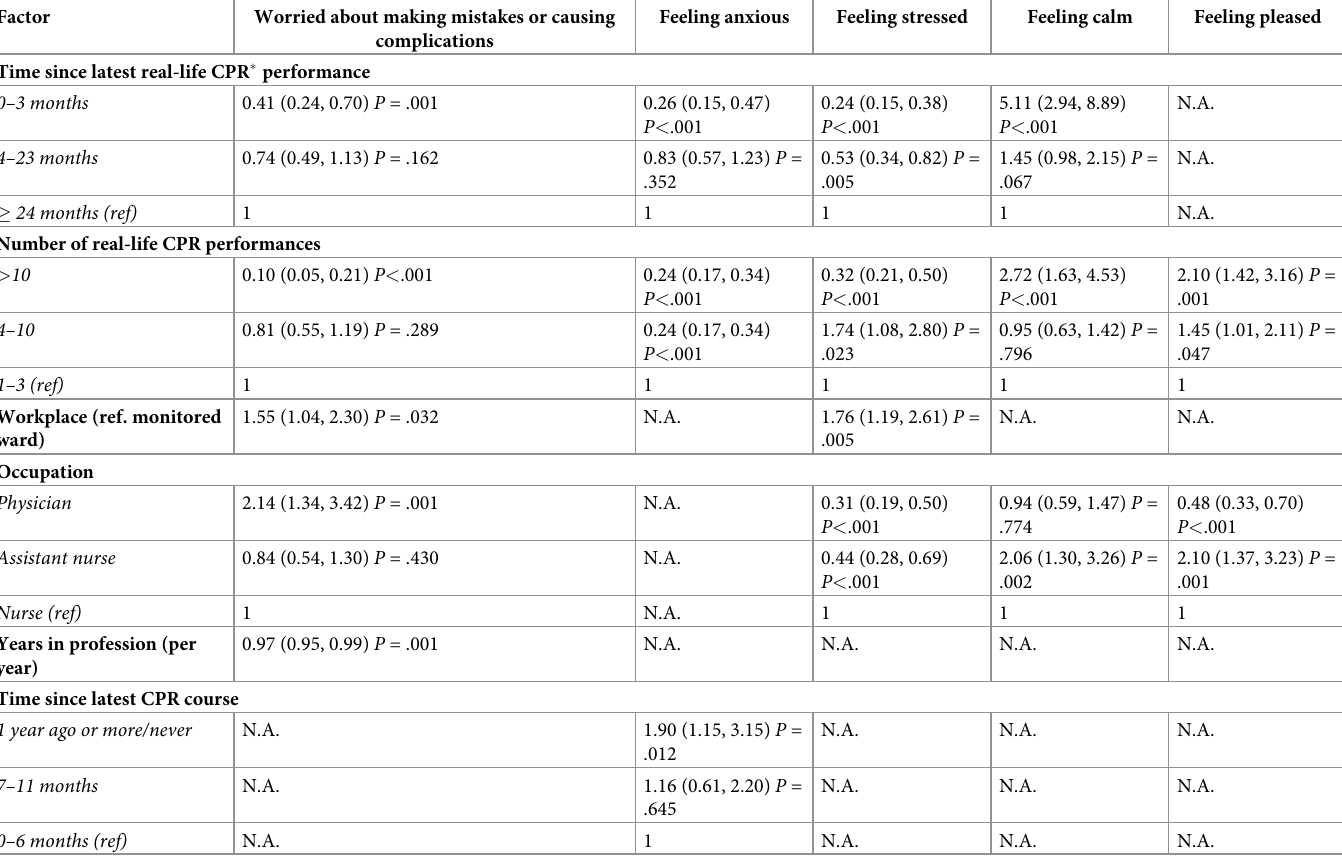
Table 4. Factors associated with attitudes in connection to the latest real-life cardiac arrest situation.